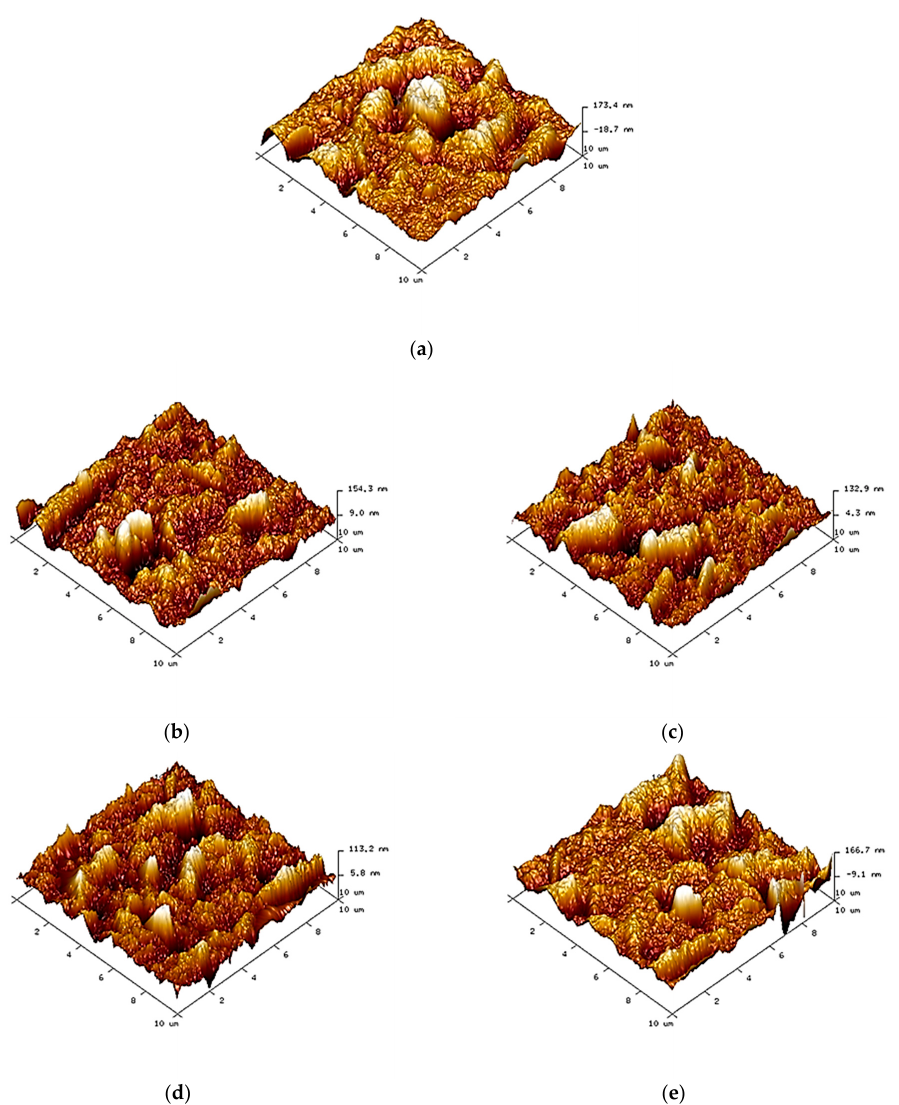
Figure 1. Atomic force microscope (AFM) images of: ( a ) PD-neat; ( b ) PDNC-I; ( c ) PDNC-II; ( d ) PDNW-I; and ( e ) PDNW-II membranes.